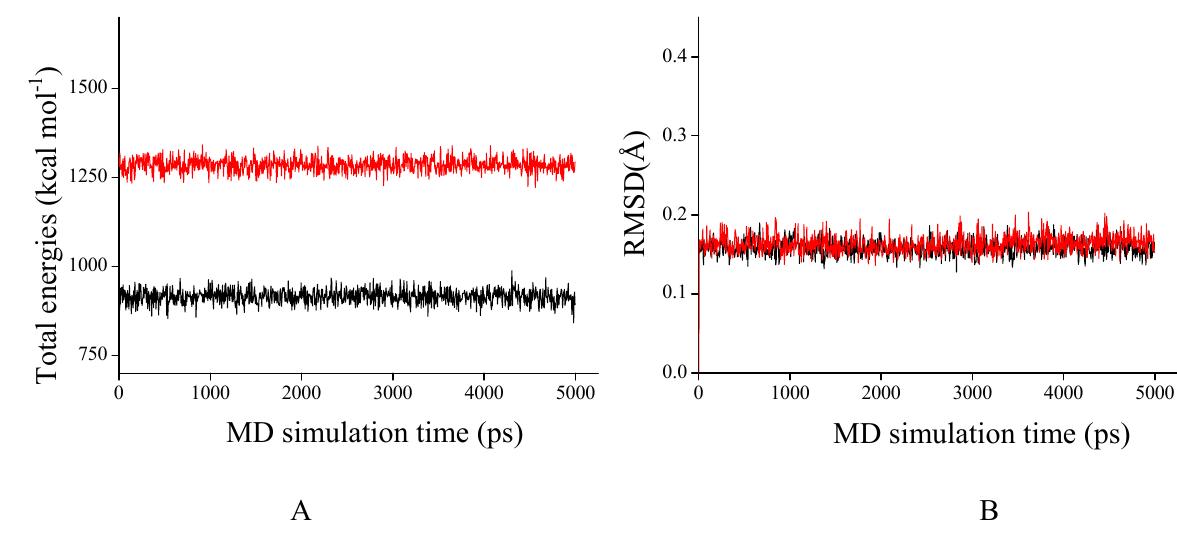
Figure 3. The time-evolution total energies (A) and backbone-atom root mean square deviations (RMSD, B) for the docked complexes during the MD